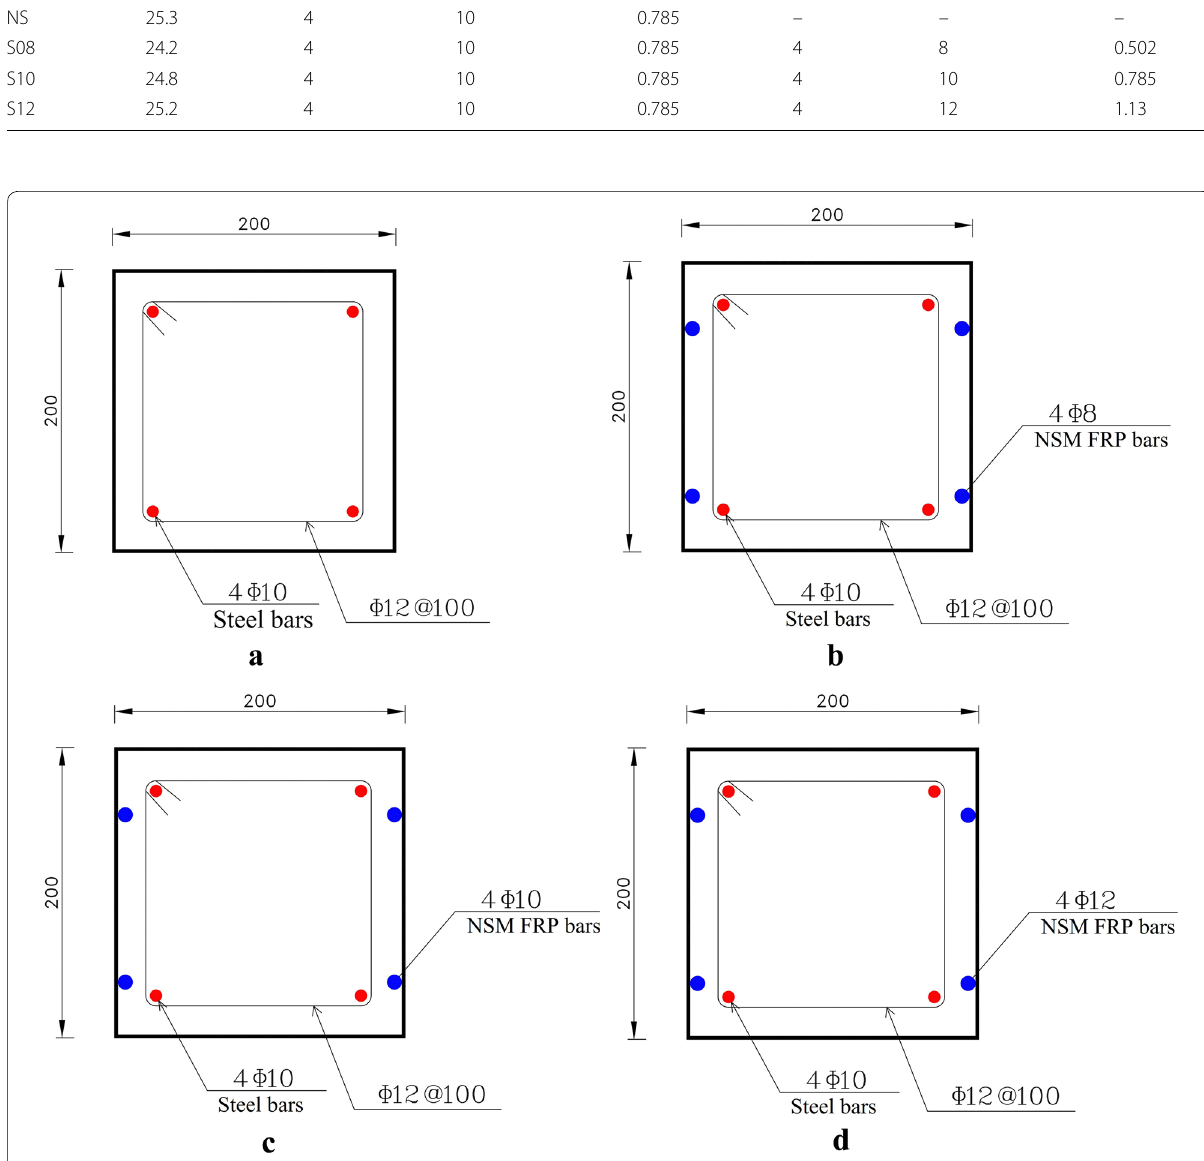
Fig. 1 Cross section of specimens: a NS; b S08; c S10; d S12 (unit;